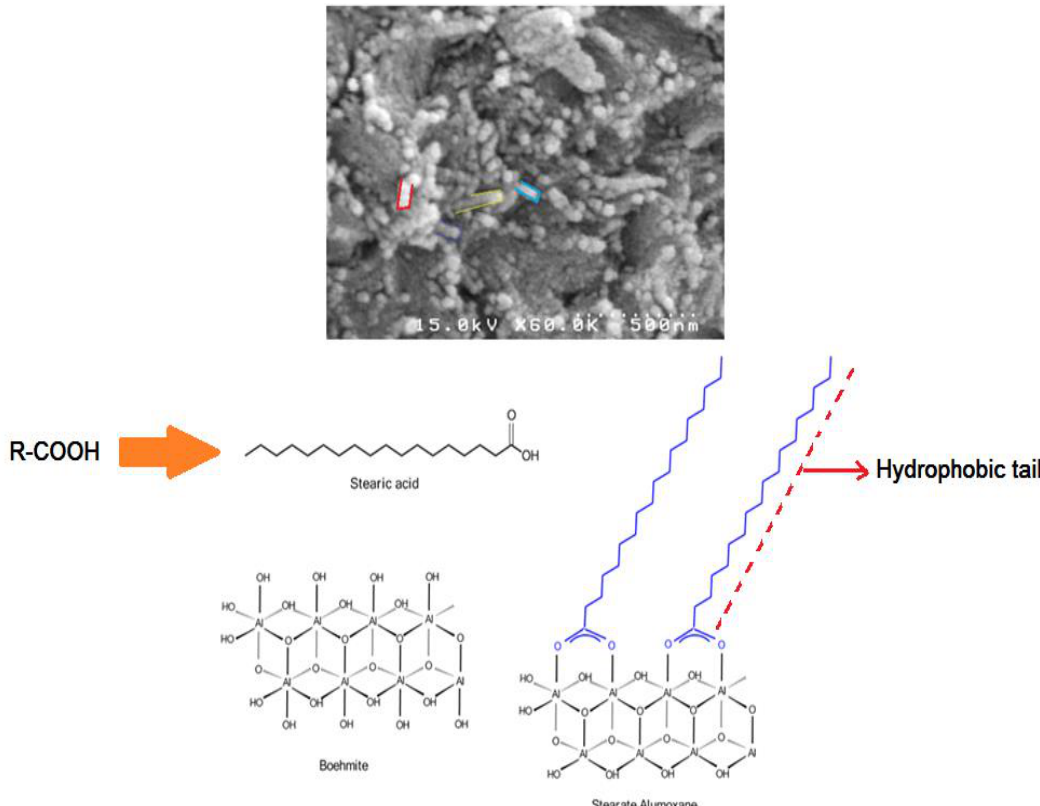
Fig. 6. The chemical structure of Fig. 6